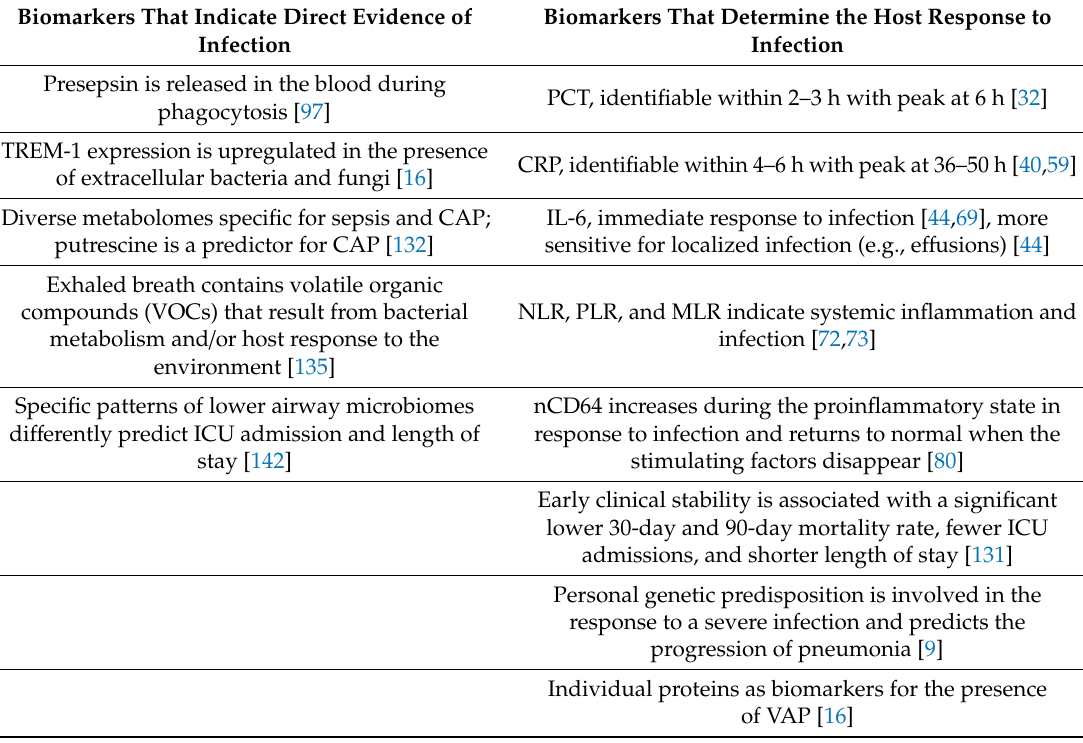
Table 2. Summary of the biomarkers that indicate a direct evidence of infection and those that indicate the host’s response to